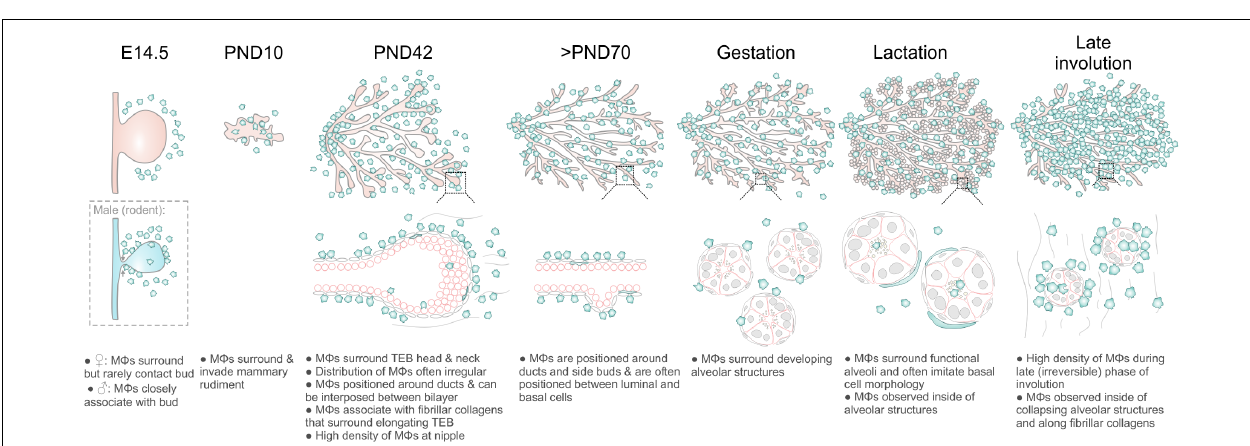
FIGURE 6 | Diagram summarizing M φ distribution in the mouse mammary gland during distinct phases of development and